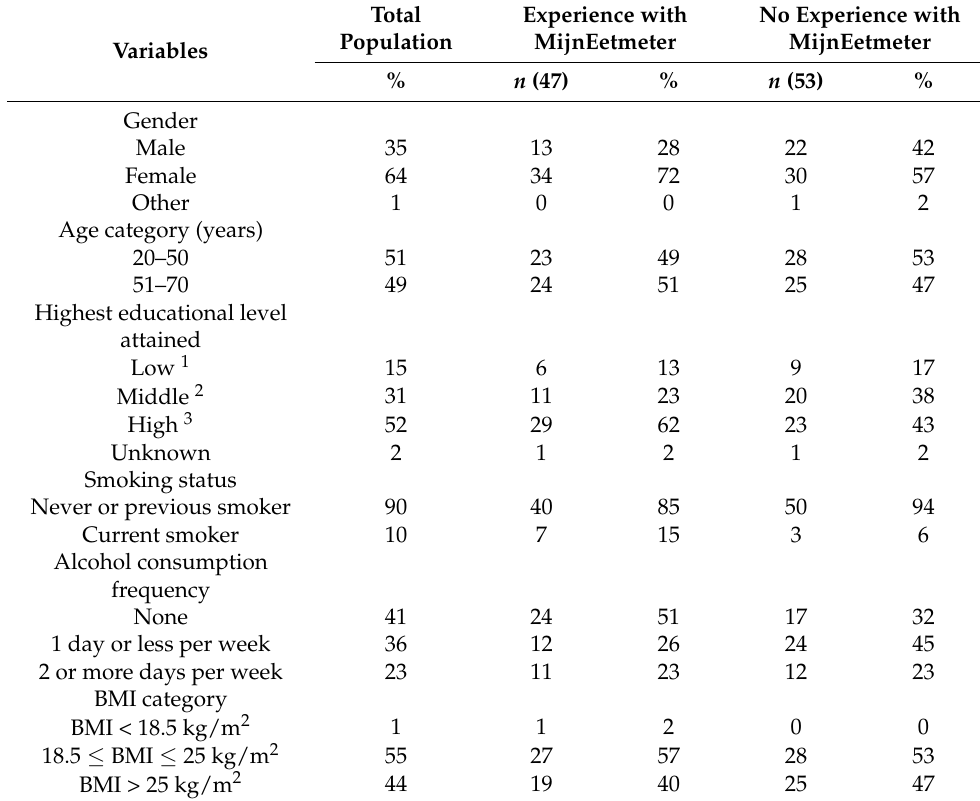
Table 1. Participant characteristics in MijnEetmeter-study ( n =